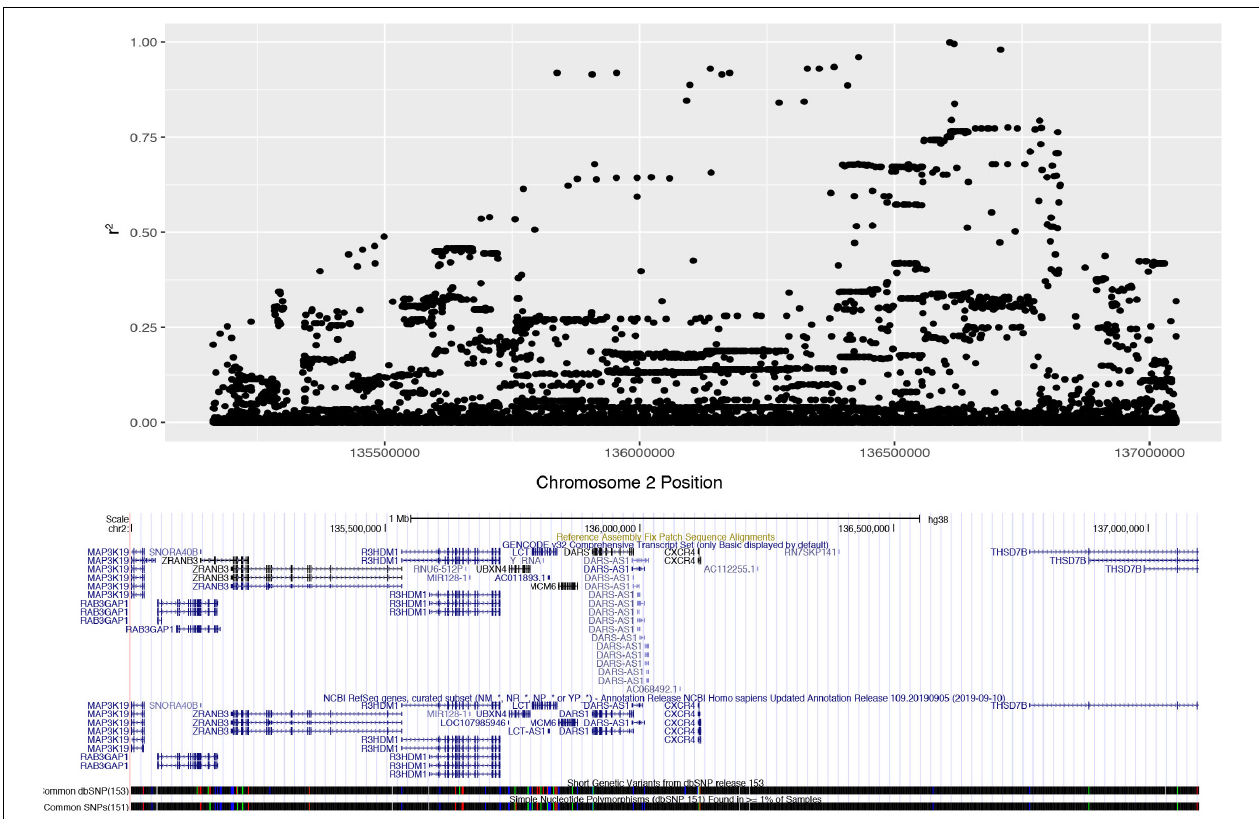
FIGURE 1 | Expanded Manhattan plot of lactase persistence haplotype block on chromosome 2 encompassing nine genes and one microRNA found in the human GRCh38 assembly. SNPs associated ( r 2 > 0.2) with rs4988235 (chr2:135,851,076) span from rs3791298 (chr2:135,163,759) to rs6706934